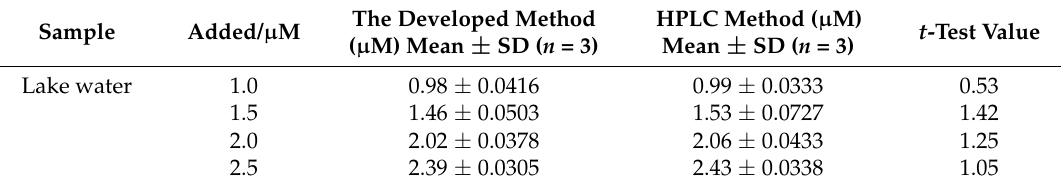
Table 2. Determination of phenol spiked in lake water sample by the proposed biosensor.